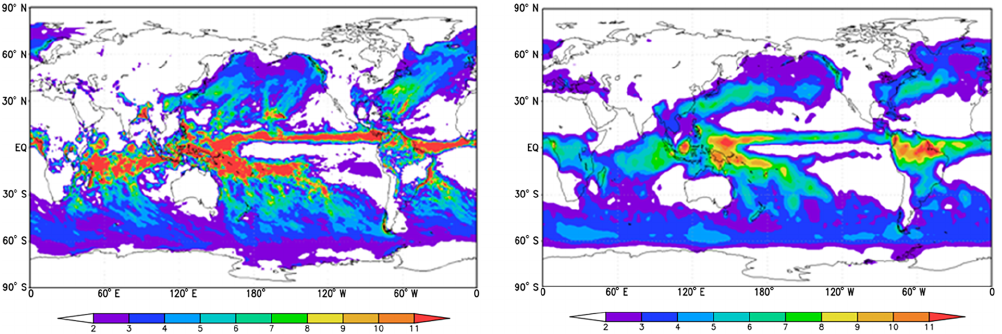
Figure 4. February to April (FMA) 1996 mean precipitation (mmday − 1 ) from GEF (a) and GPCP (b)